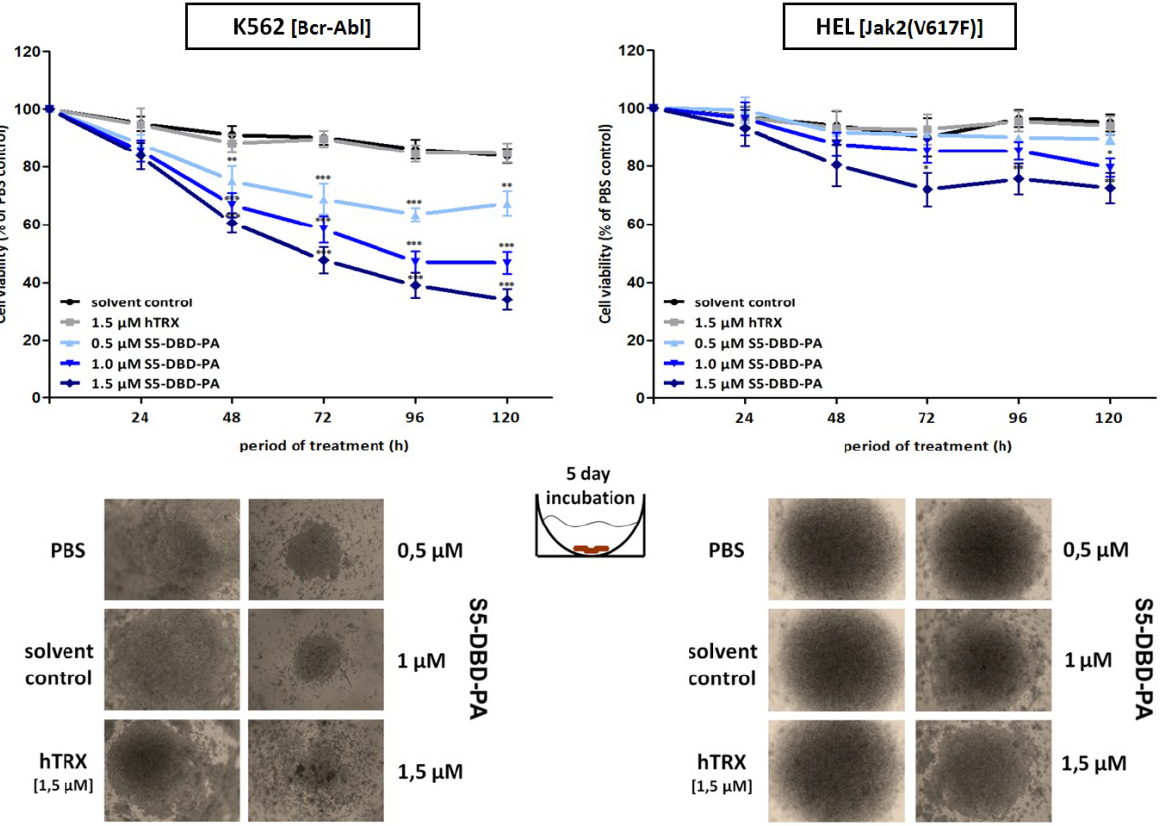
Figure 7. Suppression of K562 and HEL leukemic cell growth and viability by the recombinant cell-penetrating S5-DBD-PA. S5-DBD-PA protein was added to the culture media of K562 and HEL cells in final concentrations of 0.5, 1, 1.5 µM. For negative control 1.5 µM of the non-specific hTRX scaffold protein construct and the same volumes of protein-solvent (dialysis buffer) and PBS were added. Medium and proteins were replaced daily and